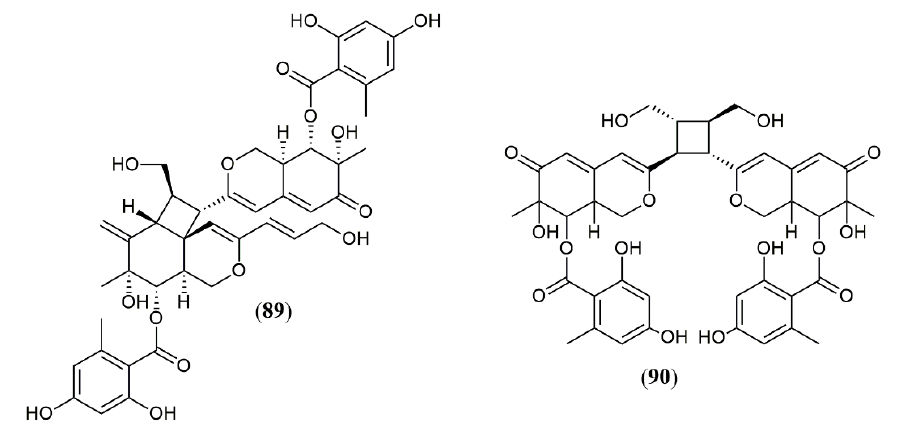
Figure 8. Chemical structures of azaphilones from Pleosporales : 89–90 : pleosporales A and B [57].